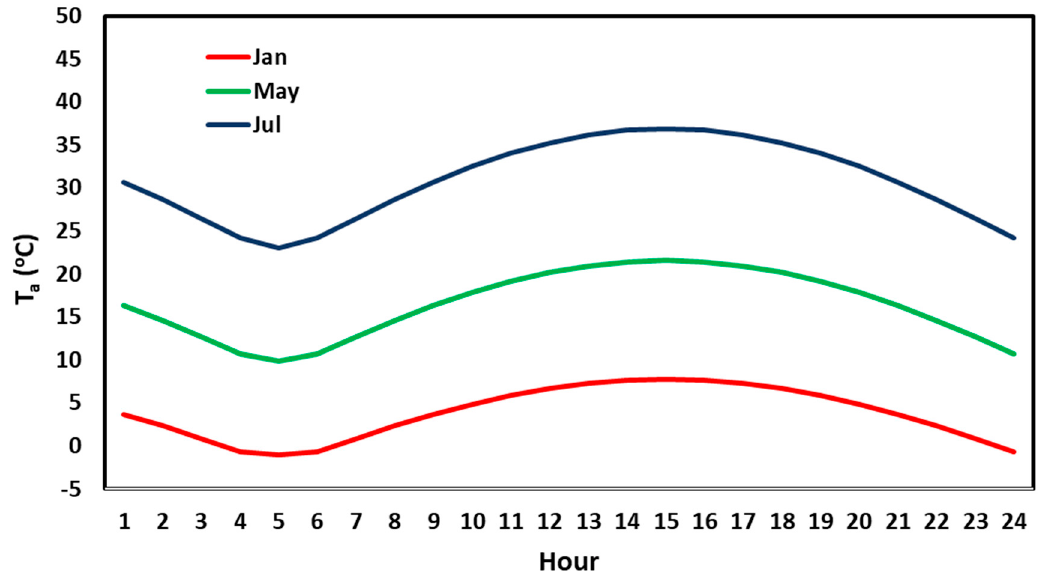
Figure 3. Average temperature changes of 15th of January, May, and July.